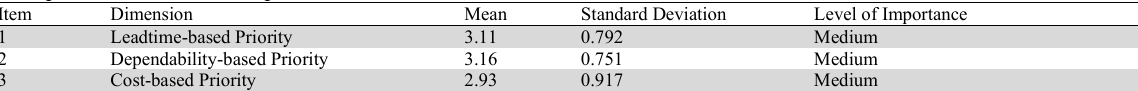
Descriptive statistics for Competitive Priorities